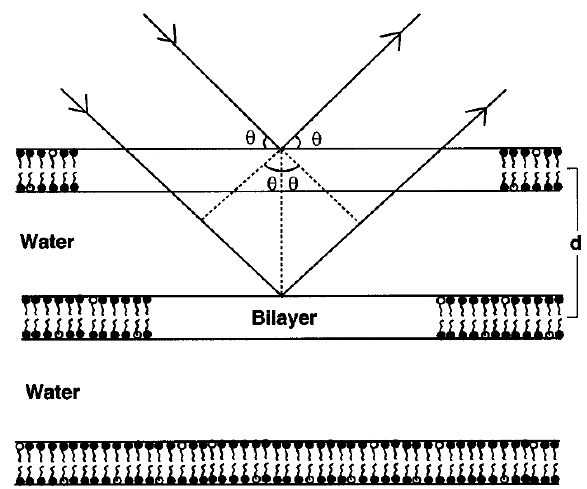
ff raction from bilayers reproduced with permission from G.M Figure 4. Schematic diagram of X-ray diffraction from bilayers according to Ecclestone [13]. Figure 4. Schematic diagram of X-ray di